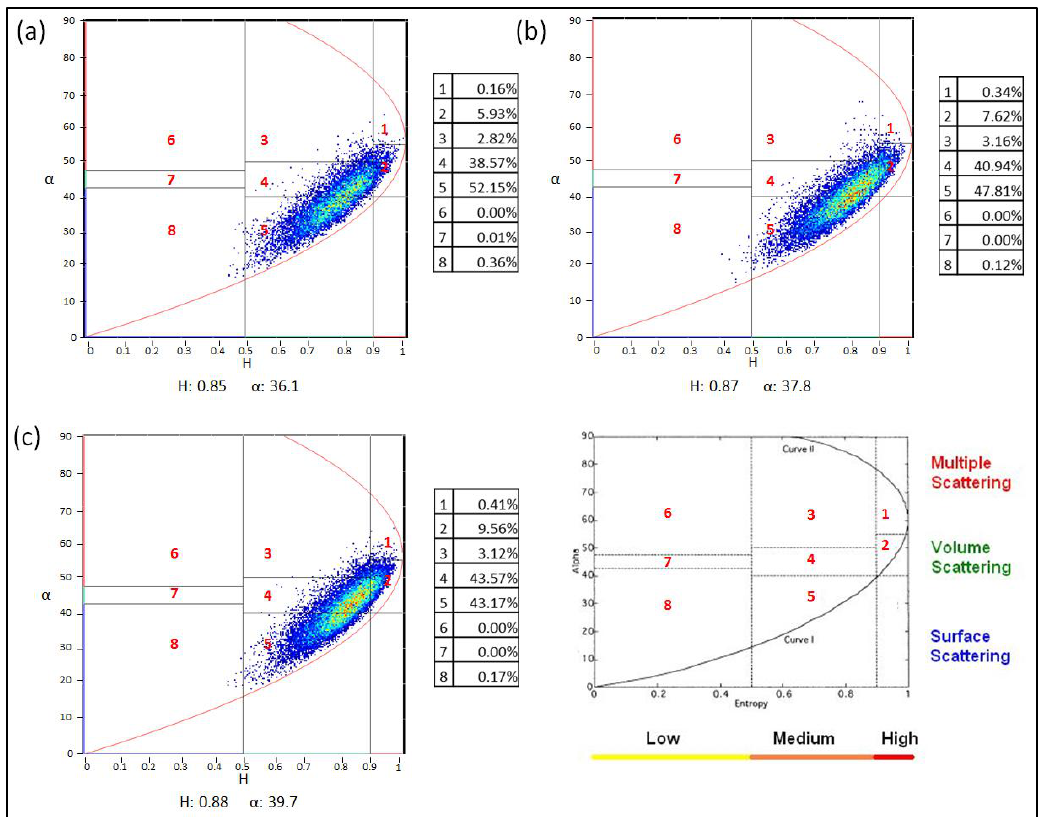
Figure 7. Forest Cloude-Pottier H/α decomposition based on RADARSAT-2 fine-quad beam modes for ( a ) 11 July; ( b ) 7 August; and ( c ) 24